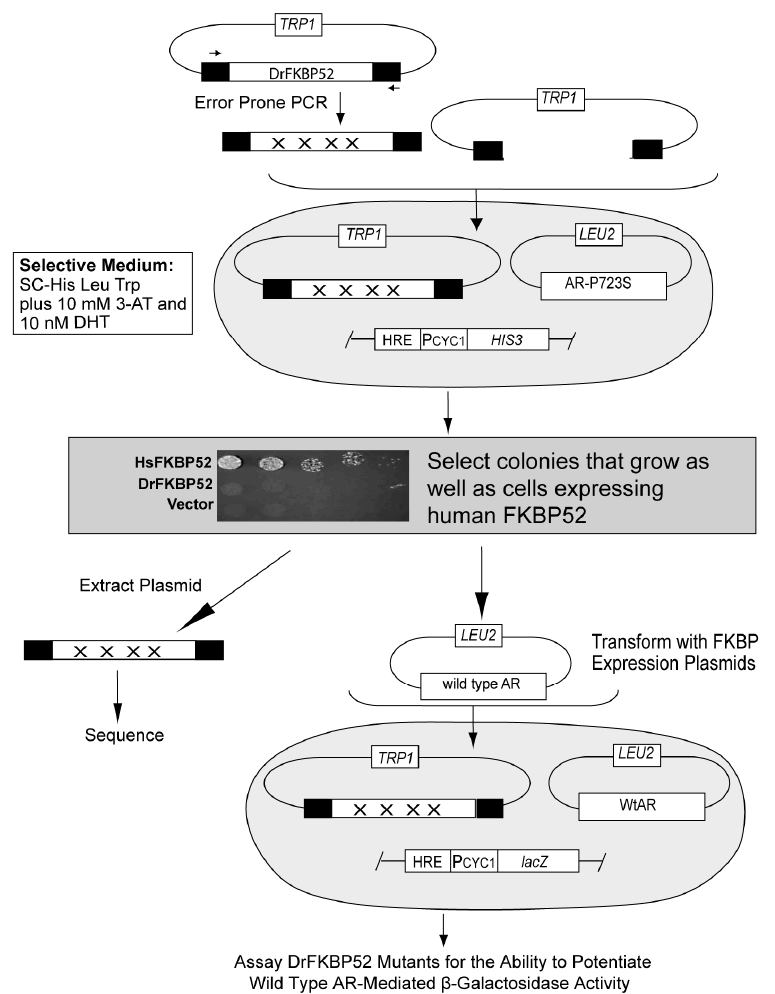
Figure 2. Selection scheme for Danio rerio FKBP52 gain-of-function mutants. Libraries of random Dr FKBP52 mutants were independently generated by error-prone PCR using primers (horizontal arrows) binding upstream in the GAPDH promoter (PGPD) or downstream in the transcriptional